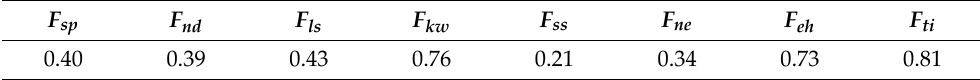
Table 4. Example of chromosome from the initial